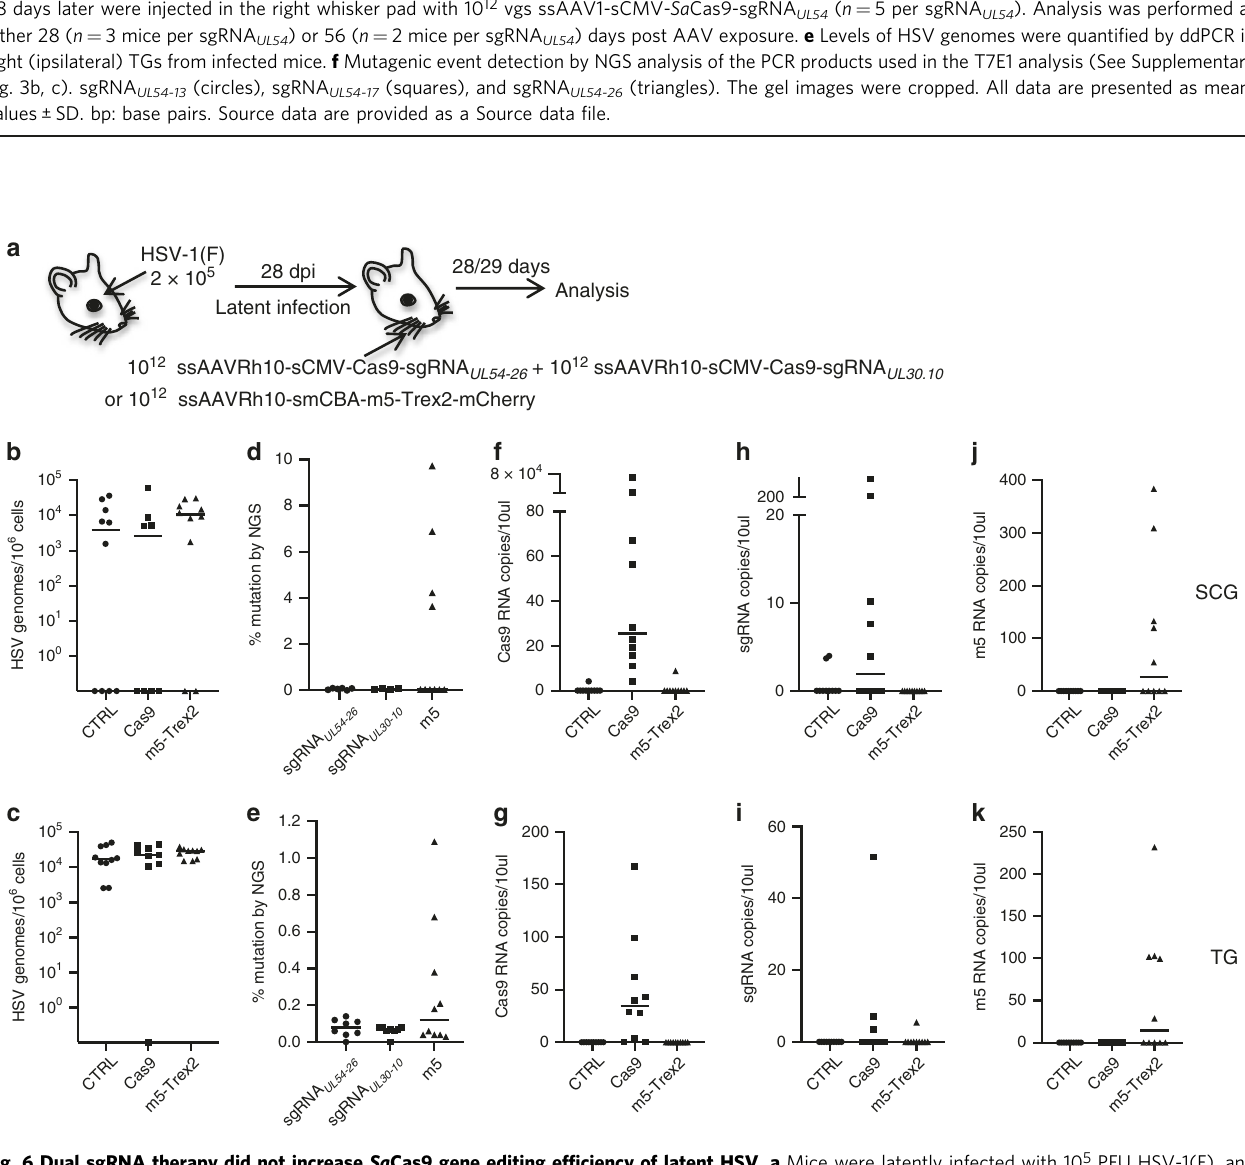
Fig. 6 Dual sgRNA therapy did not increase Sa Cas9 gene editing ef fi ciency of latent HSV. a Mice were latently infected with 10 5 PFU HSV-1(F), and 28 days later were left untreated (CTRL, n = 10 circles) or administered by RO injection either dual sgRNA therapy consisting of 10 12 vgs ssAAVRh10- sCMV- Sa Cas9-sgRNA UL54-26 and 10 12 vgs ssAAVRh10-sCMV- Sa Cas9-sgRNA UL30-10 (Cas9, n = 10 squares) or meganuclease therapy of 10 12 vgs ssAAVRh10-smCBA-m5-Trex2-mCherry (m5 + Trex2, n = 10 triangles). At 28-29 days post AAV exposure b , c levels of HSV genomes were quanti fi ed by ddPCR in SCGs and right (ipsilateral) TGs from infected mice. d , e NGS analysis was performed to detect mutation at the site targeted by either sgRNA UL54- 26 , sgRNA UL30-10 or m5 in latent HSV from SCG and TG of treated mice. f , g Detection of Cas9 mRNA by RT-qPCR in SCG ( f ) and TG ( g ) of infected mice. h , i Detection of sgRNA by RT-ddPCR in SCG ( h ) and TG ( i ) of infected mice. j , k Detection of m5 mRNA by RT-qPCR in SCG ( j ) and TG ( k ) of infected mice. All data are presented as mean values± SD. Source data are provided as a Source data fi